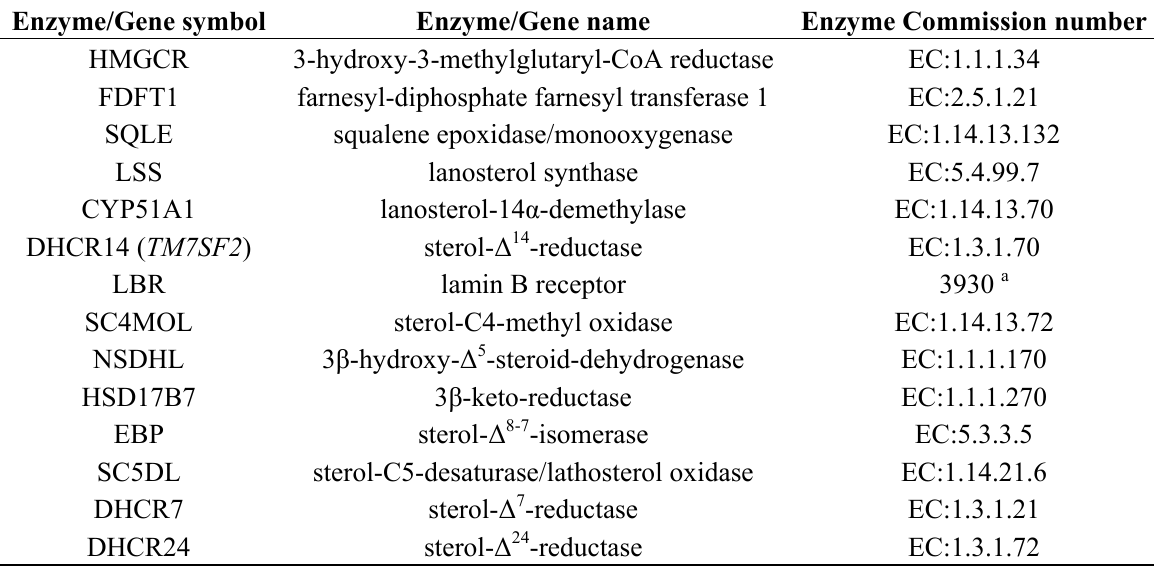
Table 1. Enzymes/gene symbols, names and Enzyme Commission numbers. Enzyme/Gene symbol